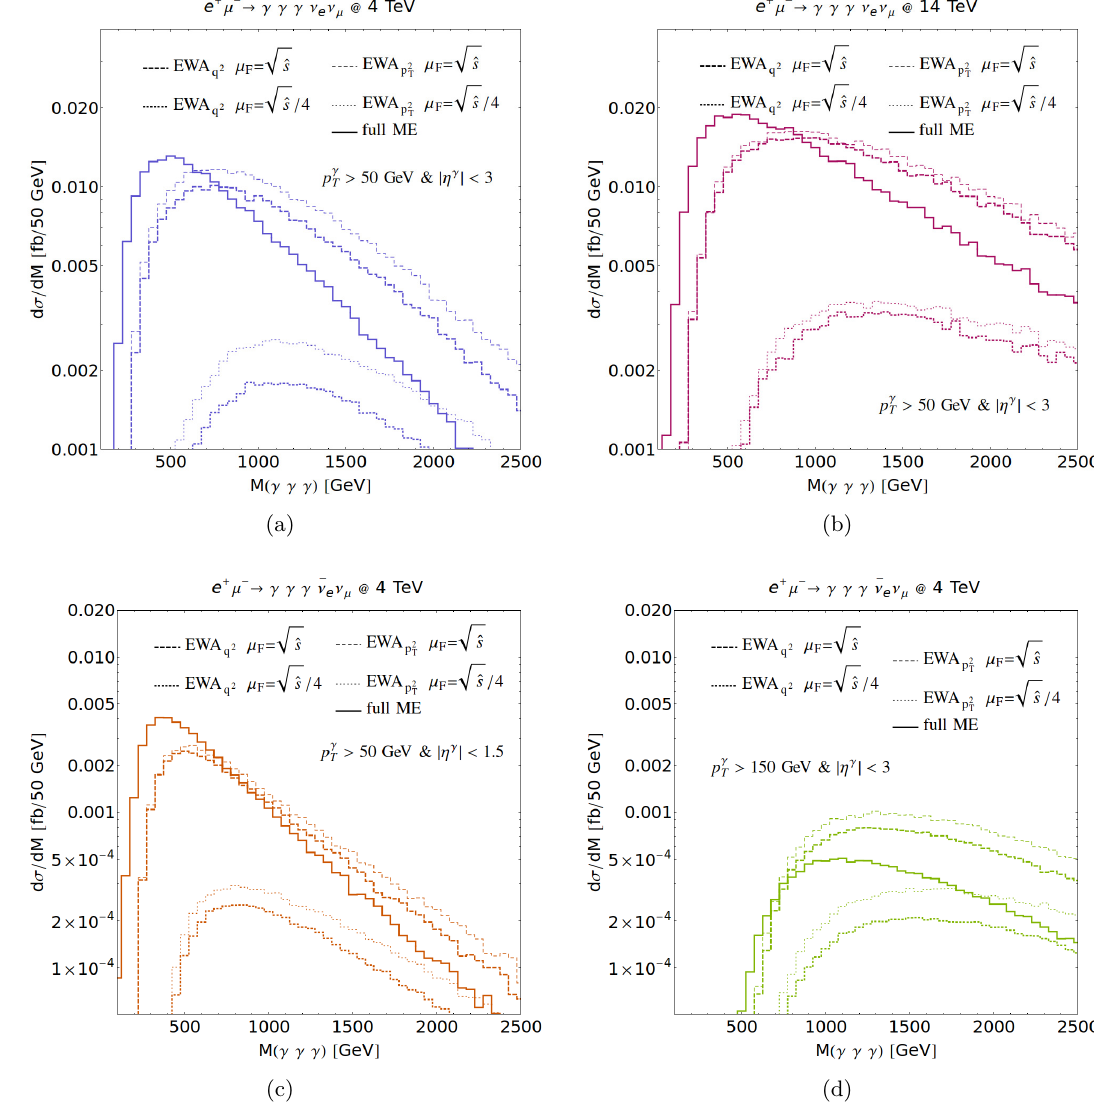
Figure 4 . (a) The invariant M ( γγγ ) distribution of the process W + W − → γγγ , as predicted by the full 2 → 5 ME (solid) and the EVA W + evolution by virtuality q 2 (thick lines) and transverse momentum p 2 (dash) and µ = M ( γγγ ) / 4 (dots). (b) The same as (a) but for f but for | η γ | < 1 . 5 . (c) The same as (a) but for p γ